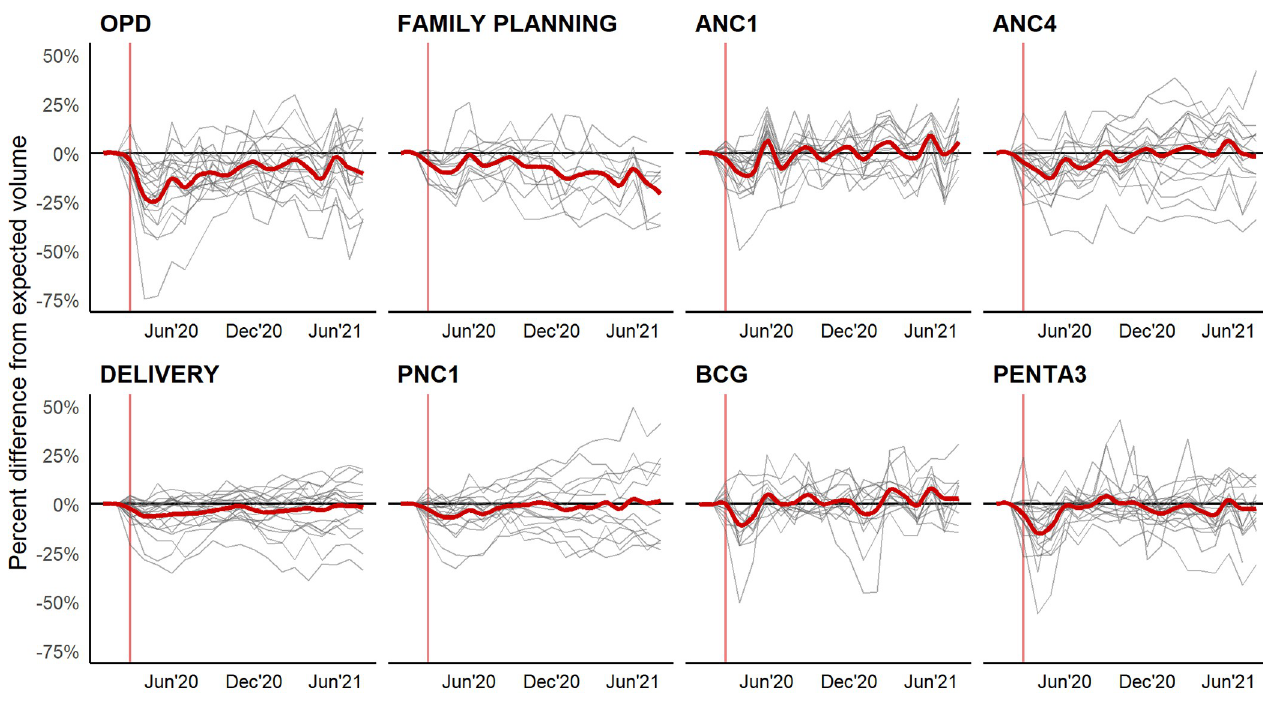
Fig 1. Percent change in volume from expected levels based on prepandemic trends by selected health services across 18 countries, March 2020–February 2021. Note: The horizontal line at 0% represents the expected volume of services based on prepandemic trends. The gray lines plot country-specific changes in service utilization. The monthly country-specific results are presented in Table A in S1 Text. The red line is a multicountry unweighted moving average of the change in utilization plotted by a locally estimated scatterplot smoothing (LOESS) regression. Details on indicator reporting for each country can be found in Table L in S1 Text. ANC1 refers to First Antenatal Care Visit. ANC4 refers to the Fourth Antenatal Care Visit. BCG refers to bacillus Calmette–Gue´rin vaccination. OPD refers to Outpatient visits. Penta3 refers to the Third dose of Pentavalent vaccine. PNC1 refers to First Postnatal Care